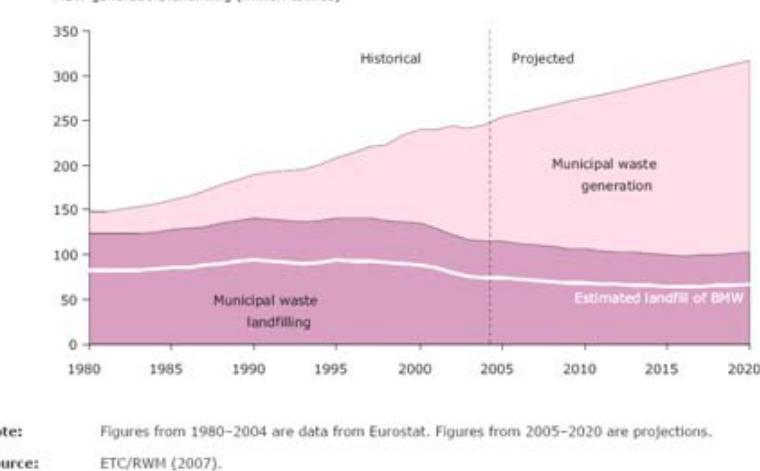
Figure 28: Projected generation and landfilling of municipal waste in the EU-25 Because of the increase of the 25 % MSW generation will probably include an increase of biodegradable municipal waste (BMW) amounts on the same level until 2020 additional efforts for BMW diversion and treatment will be required. The necessary capacities are already insufficient now therefore the study concluded that "based on the current policies it is estimated that based on the current policies the EU 25 will not meet them (= the targets). Thus, more efforts are required if targets have to be